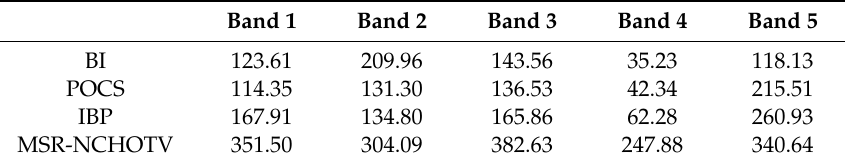
Table 6. Evaluation results for image SNR for Experiment 2.